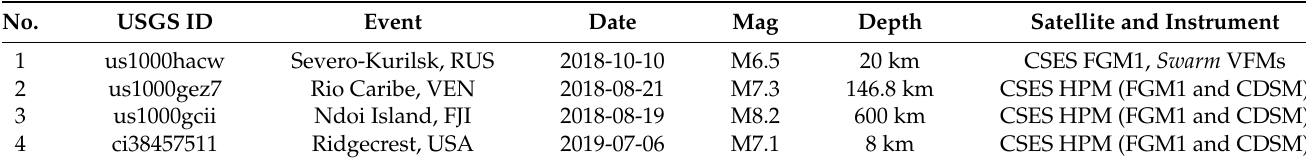
Table 2. Investigated earthquakes with space based magnetic field measurements by LEO satellites.